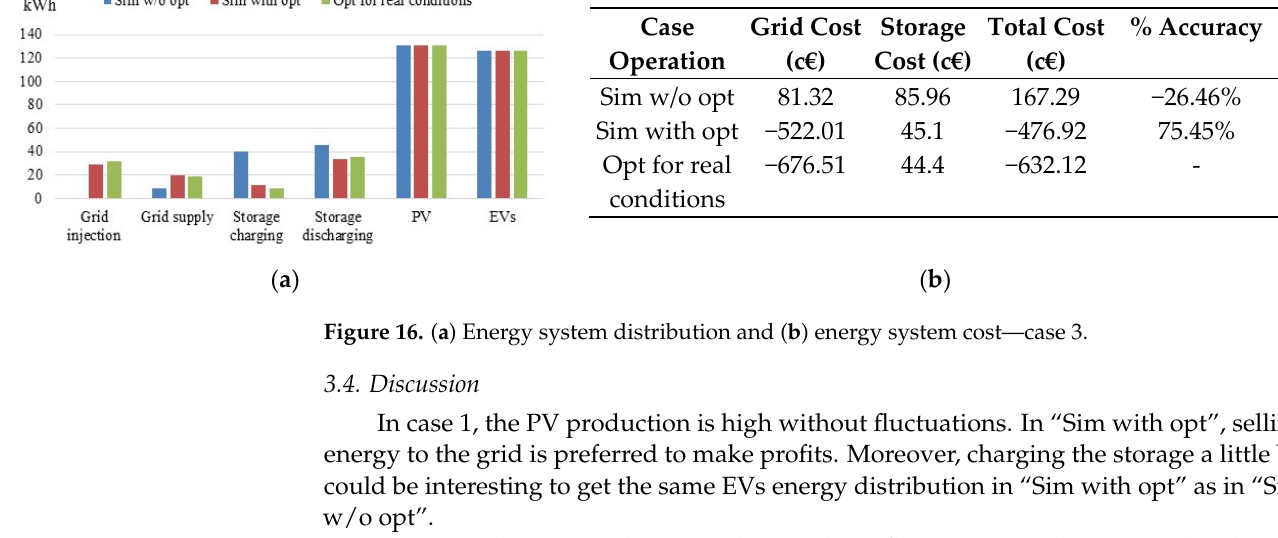
Figure 16. ( a ) Energy system distribution and ( b ) energy system cost—case 3.